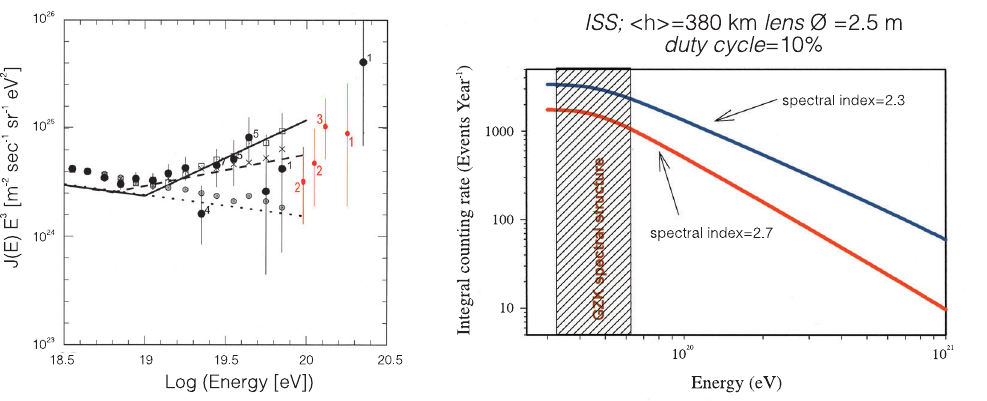
Fig. 9. ( Left ) This is fi g. 10 from Yoshida et al. (1995): «Derived primary energy spectra expressed by eqs. (11a) (solid line) and (11b) (dashed line) and the expected values in each bin simulated under the assumptions of these spectra with the energy resolution of the present experiment (open squares and crosses). Black dots with error bars are the raw data. The case of a single power up to the highest energy is also shown by a dotted line and shaded circles.» The slope of the continuous line above 10 19 eV is 2.3; for the dashed line the slope is 2.7. The superimposed red points are from Takeda et al. (1998). ( Right ) EUSO counting rates under the hypothesis of the two different spectral index assumed (see fi g. 1 left